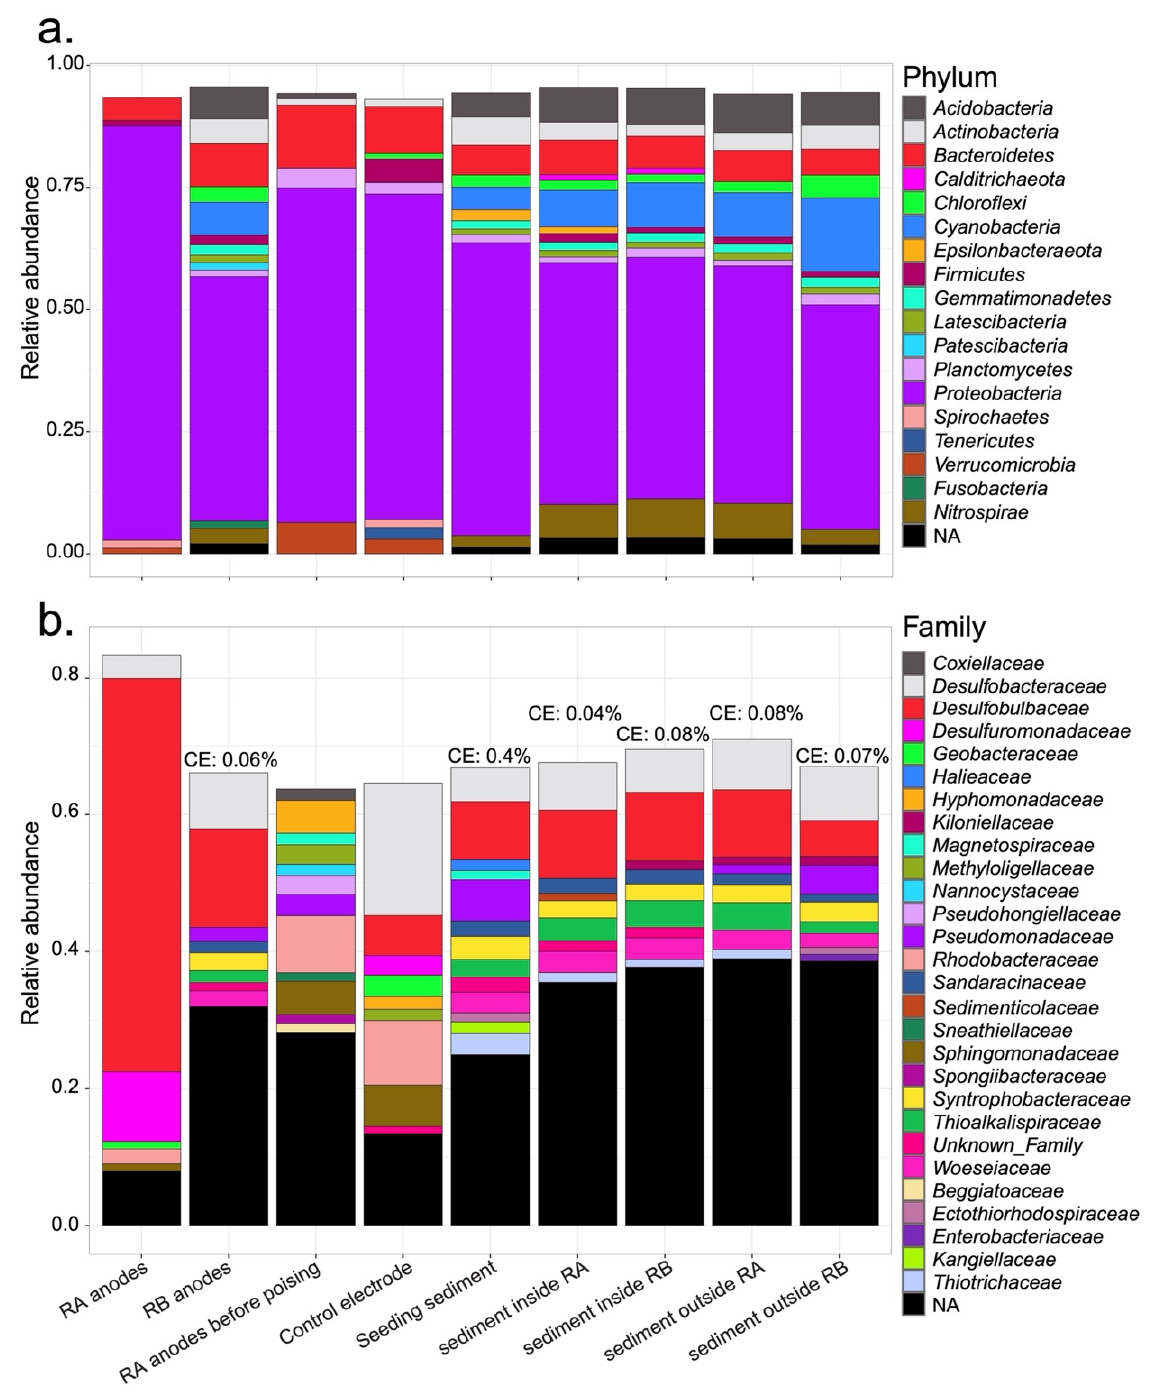
Figure 2. The relative abundances of ( a ) phyla and ( b ) families within Proteobacteria covering >1% of microbial communities. CE: a candidate cable bacteria genus, Ca. Electrothrix. NA stands for those that have not been assigned by the SILVA 132 database. Unknown Family is a family within the Proteobacteria that have been recognized by the SILVA 132 database but has not been given a name.